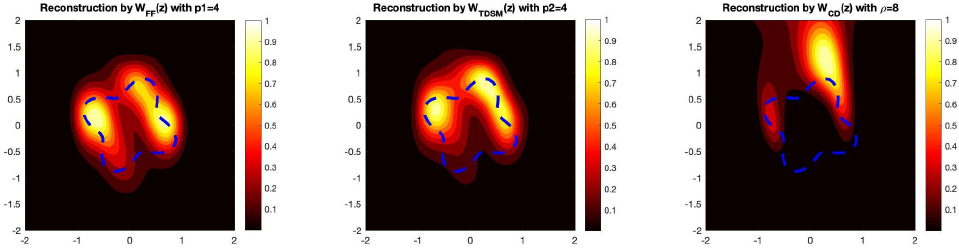
Figure 9. The reconstruction of the flower-shaped obstacle with 1/2 partial aperture data. In this example, we take δ = 0.05, which corresponds to a 5% noise